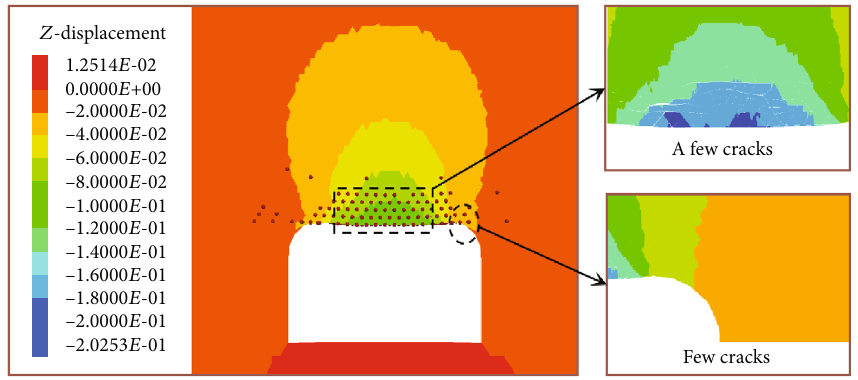
Figure 13: Crack development in roadway roof after the improvement of the support scheme.